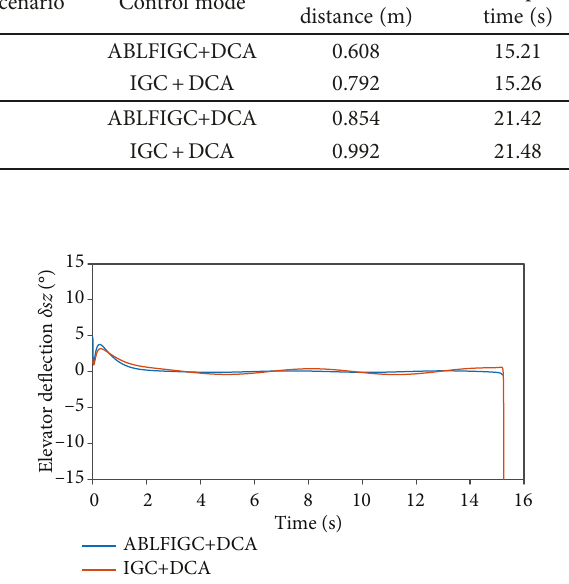
Figure 14: Curves of elevator de fl ection angle δ : ABLFIGC+DCA z refers to a combination of the proposed asymmetric barrier Lyapunov function-based IGC algorithm and the dynamic control allocation algorithm; IGC+DCA refers to a combination of the IGC algorithm subject to the traditional dynamic surface sliding- mode control law and the dynamic control allocation algorithm.